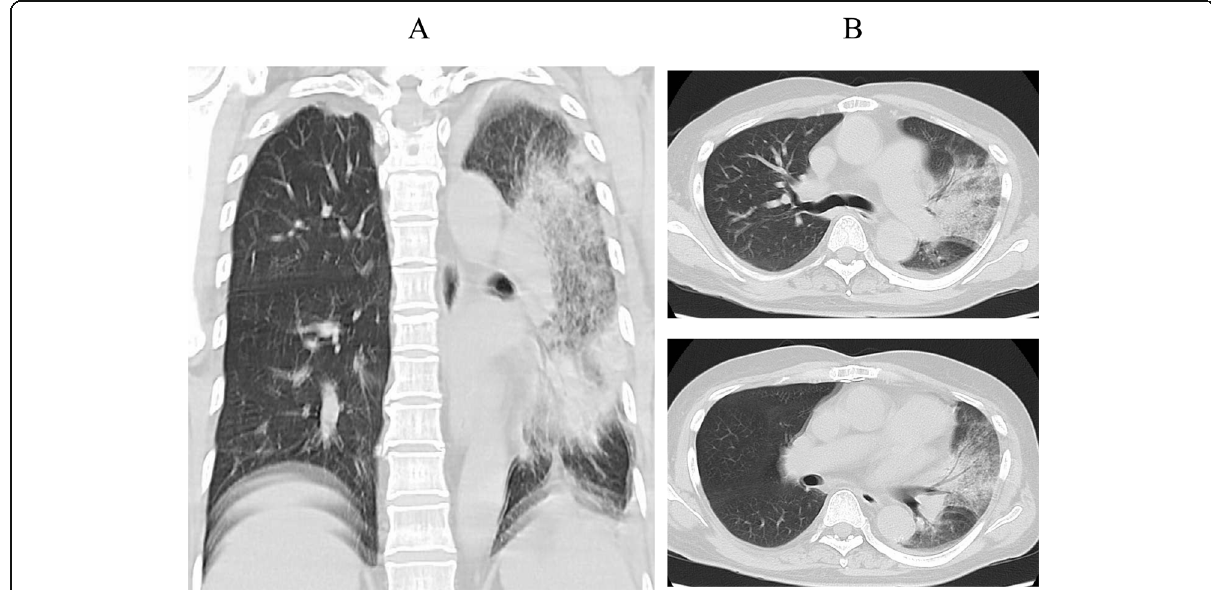
Fig. 1 Chest computed tomography (CT) on admission. Chest CT on contrast coronal ( A ) and axial ( B ) views showing infiltrative shadow and pleural effusion in the upper and lower left